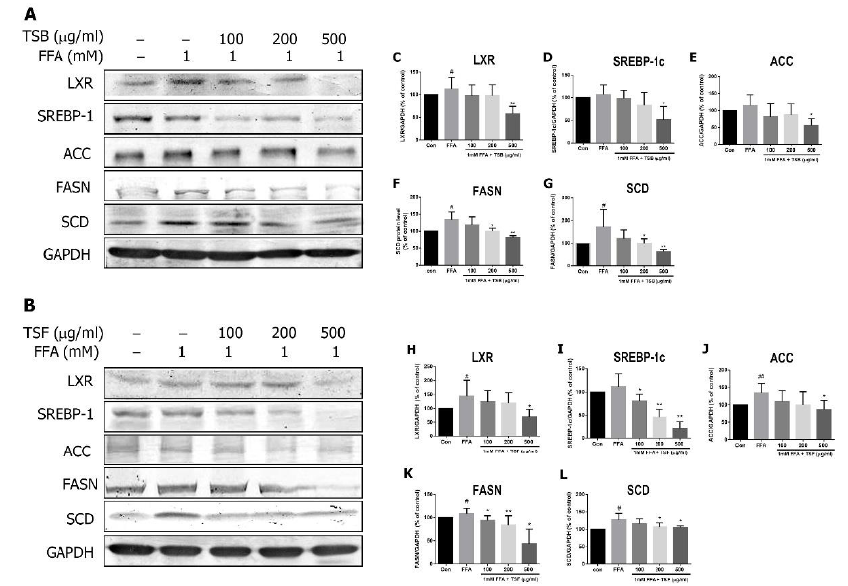
Figure 5. Effects of TSB and TSF extracts on FFA-induced lipogenic protein expression. ( A and B ) Immunoblots of lipogenic protein expression in TSB and TSF pre-treated lipid-laden HepG2 cells. GAPDH was used as the internal control. ( C – L ) The bar graphs show densitometric data (mean ± SD) from three to eight independent experiments. The images shown represent one experiment. # P < 0.05 and ## P < 0.01 compared with the control group (con). * P < 0.05, ** P < 0.01 and *** P < 0.001 compared with the FFA group. J. Clin. Med. 2019 , 8 , x FOR PEER REVIEW